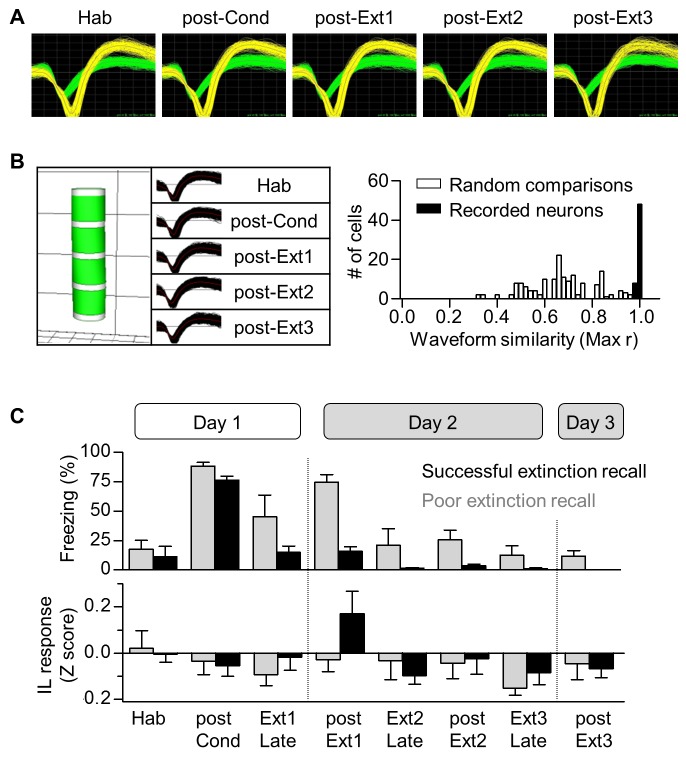
Long-term single unit recordings in the IL.(A) Representative waveforms of two neurons recorded from a single electrode and observed throughout the behavioral training period. Grid, 55 μV x 100 μs. (B) Verification of long-term stable single unit recordings using principal component space cylinders (Left) and the linear correlation analysis between the template waveforms obtained over the entire set of behavioral sessions (Right). A straight cylinder and higher correlation value suggest the same set of single units was recorded during consecutive behavioral sessions. (C) CS-evoked freezing and IL neural responses for the successful (black) and poor (gray) extinction recall groups. The behavioral and neural responses were averaged for the first 5 CSs or the last 5 CSs.